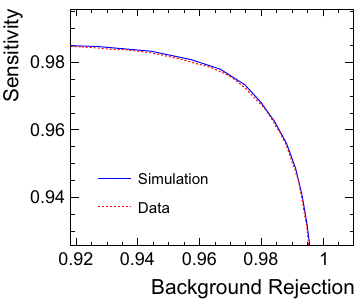
Fig. 11 ROC curve for different beam-background samples recorded in different run periods